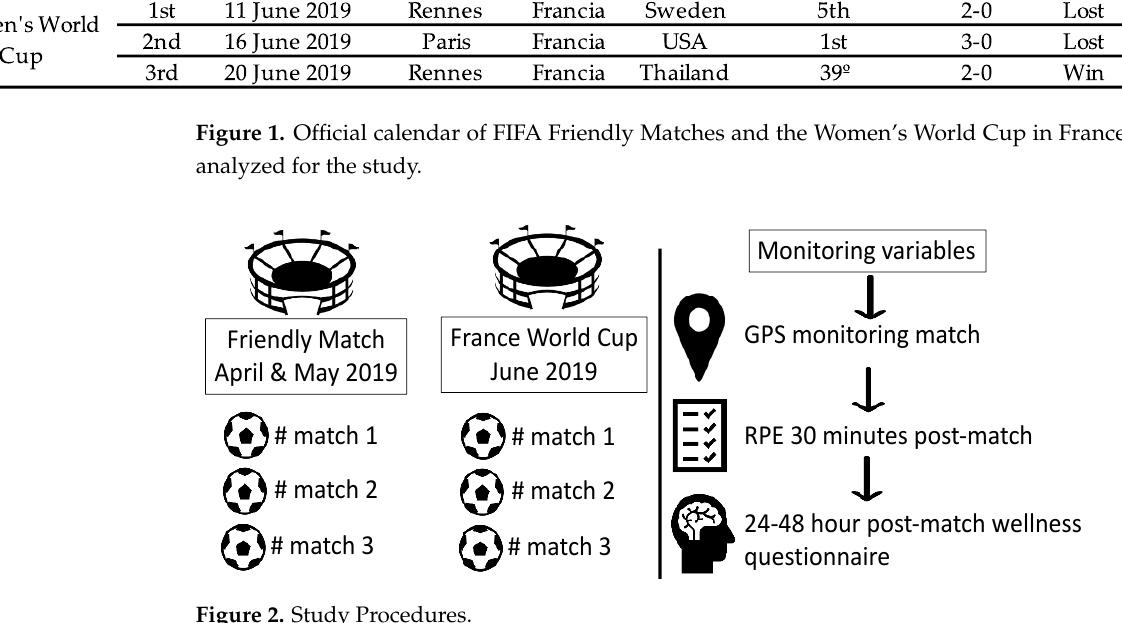
Figure 2. Study Figure 2. Study Procedures . Figure 2. Study Procedures .